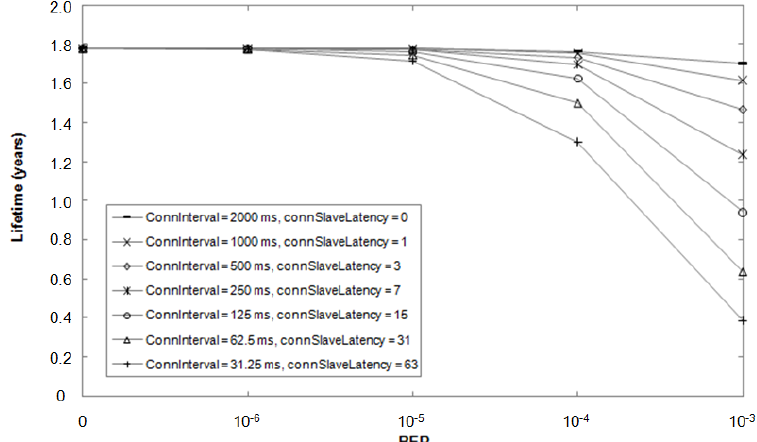
Figure 5. Theoretically expected slave lifetime for various connInterval and connSlaveLatency settings (which yield a notification rate of 0.5 Hz for BER = 0), for different BER